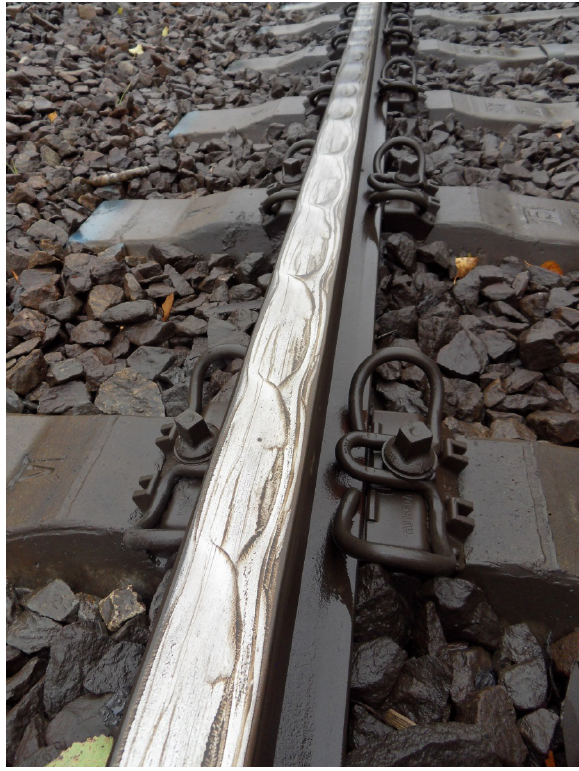
Figure 2. Highlighted long-pitch corrugation by con- taminant in Havlíčkův Brod